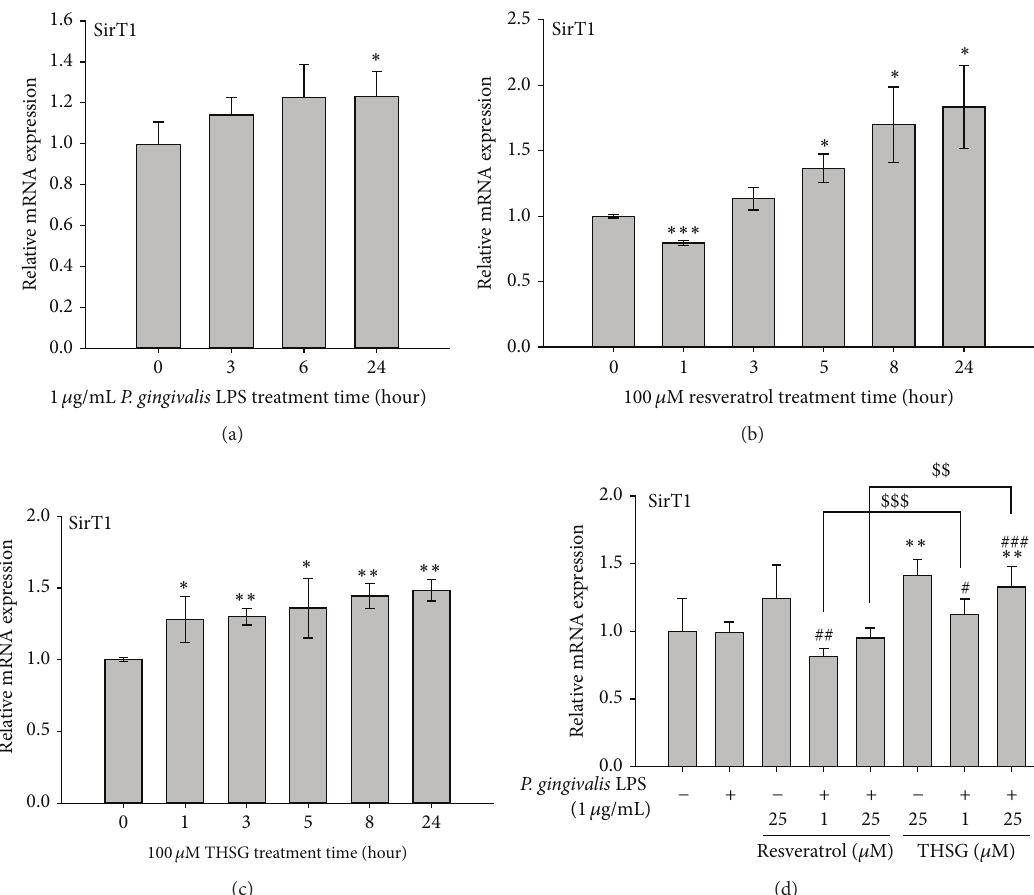
Figure 3: THSG attenuated P. gingivalis LPS-induced proinflammatory cytokines expression via inducing SirT1 expression in HGFs. HGFs were cultured in 6-well plate and were starved with serum-free DMEM/F12 medium for 24 h when the cell confluence reached 80%. (a) HGFs were treated with 1 𝜇 g/mL P. gingivalis LPS, (b) 100 𝜇 M resveratrol, and (c) 100 𝜇 M THSG for 24 h. (d) HGFs were pretreated with resveratrol and THSG (1 and 25 𝜇 M) for 30 min and then were treated with 1 𝜇 g/mL P. gingivalis LPS for 6 h. The mRNA expression of SirT1 was examined by quantitative PCR. ( 𝑁 = 3 ; ∗ 𝑝 < 0.05 ; ∗∗ 𝑝 < 0.01 ; ∗∗∗ 𝑝 < 0.001 were compared with control group. # 𝑝 < 0.05 ; ## 𝑝 < 0.01 ; ### 𝑝 < 0.001 were compared with LPS group. $$ 𝑝 < 0.01 ; $$$ 𝑝 < 0.001 were compared with 1 𝜇 M or 25 𝜇 M resveratrol group with LPS